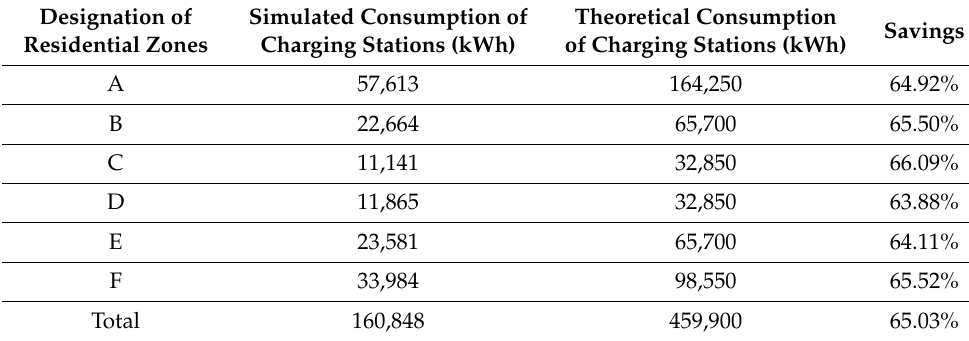
Table 19. Simulated and theoretical consumption of charging